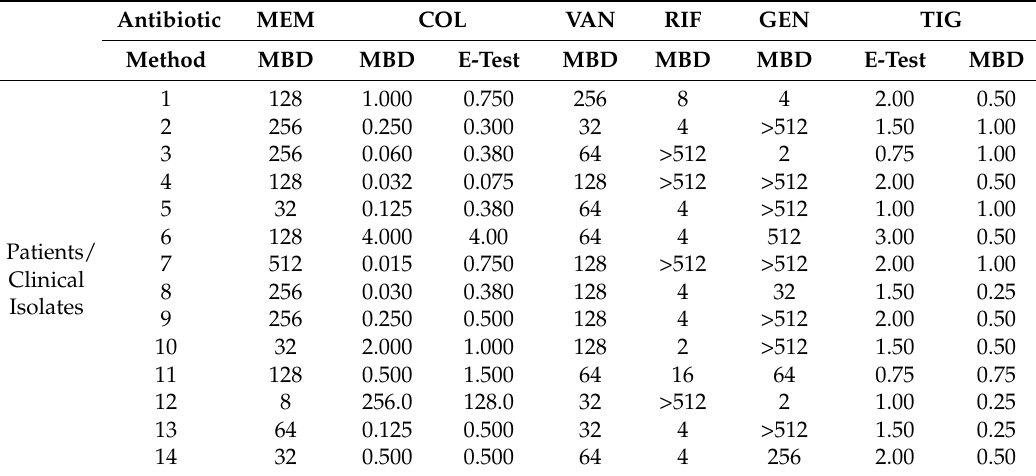
Table 2. In-vitro susceptibility of carbapenem-resistant Acinetobacter baumannii (CR-Ab) throughout macrobroth dilution (MBD) and E-test methods.